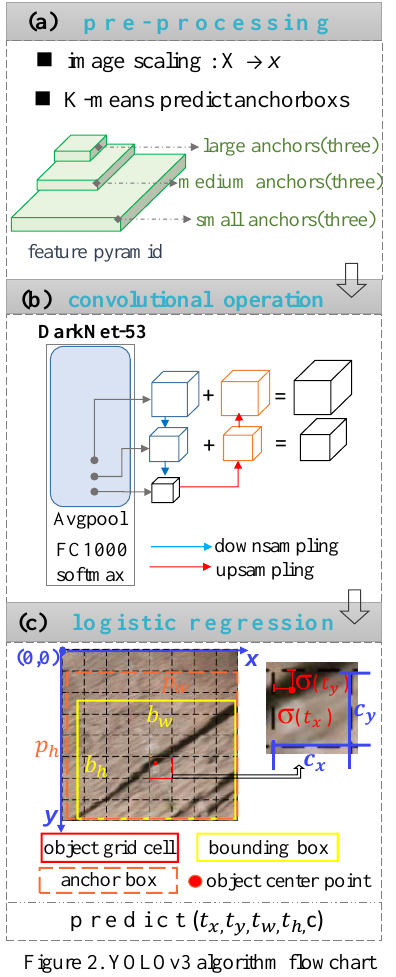
Figure 2. YOLOv3 algorithm